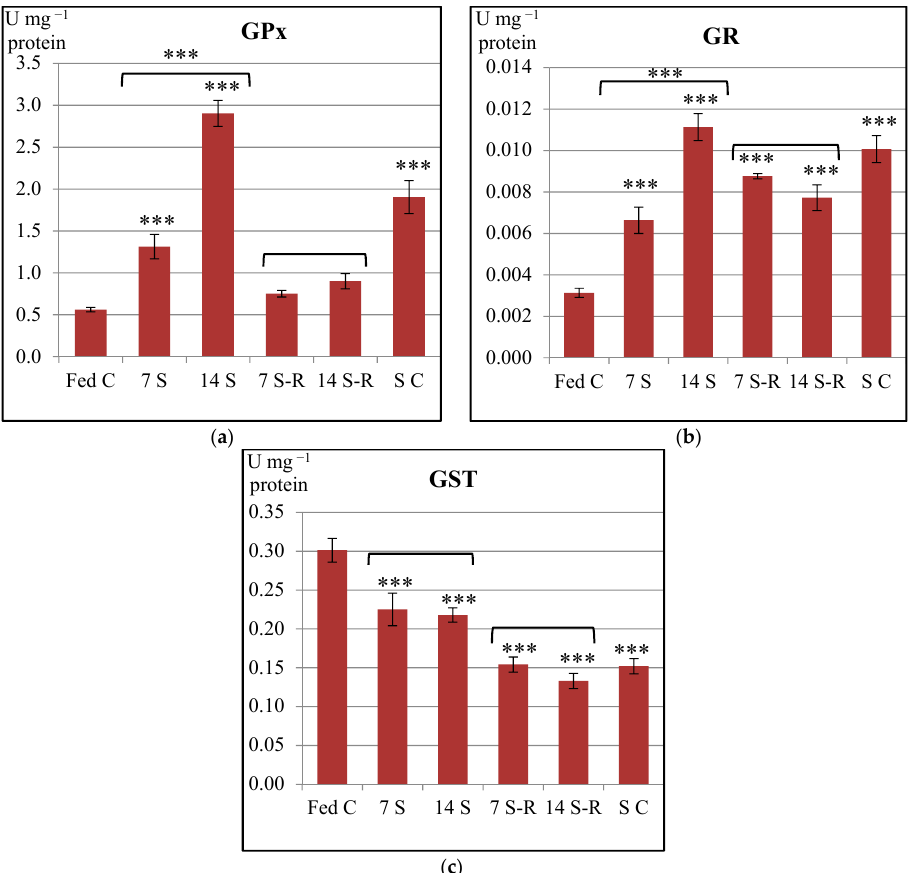
Figure 2. Specific activities of antioxidant enzymes in the intestine of Acipenser stellatus juveniles subjected to different starvation/refeeding regimes. ( a ) Glutathione peroxidase (GPx) specific activity; ( b ) glutathione reductase (GR) specific activity; ( c ) glutathione S-transferase specific activity. The data are illustrated as average value of the groups (n = 8) ± standard error of the mean (SEM). All data were statistically analyzed using one way—ANOVA. Statistical significance: *** p < 0.001; the statistical significance of the changes is related to the fed control level and it is also presented between 7 S and 14 S groups and between 7 S-R and 14 S-R groups. Fed C—fed control group; 7 S—group starved for 7 days; 14 S—group starved for 14 days; 7 S-R—group starved for 7 days and refed 21 days; 14 S-R—group starved for 14 days and refed 21 days; S C—starved control.